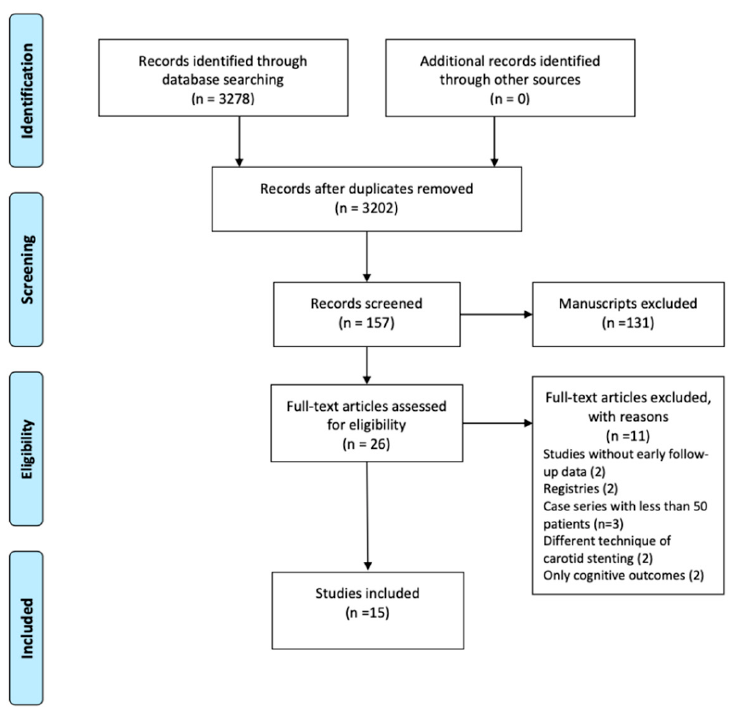
Figure 1. The present meta-analysis was conducted using the PRISMA guidelines and included 15 articles with 16,043 patients. Table 1. The studies’ characteristics.